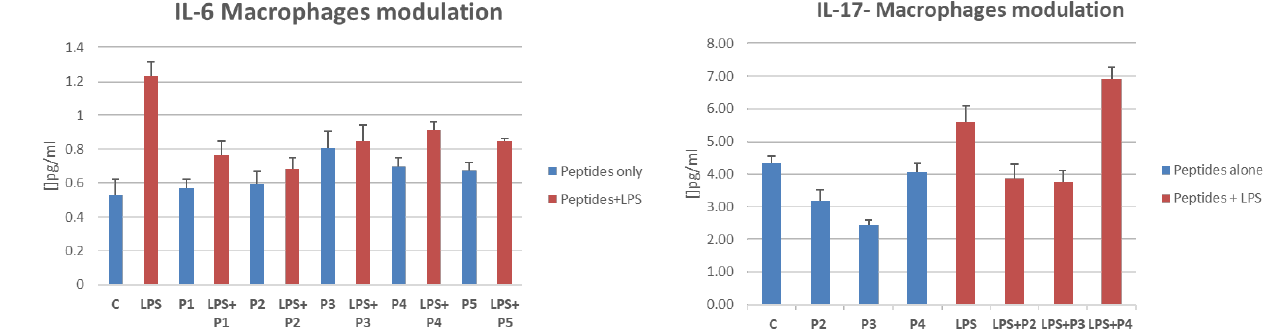
Figure 5. Macrophage cytokine modulation: TNF α , IL-6. and IL-17. Supernatants from treated cells or controls were used as described in Materials and Methods. Data are a mean of at least three independent experiments .